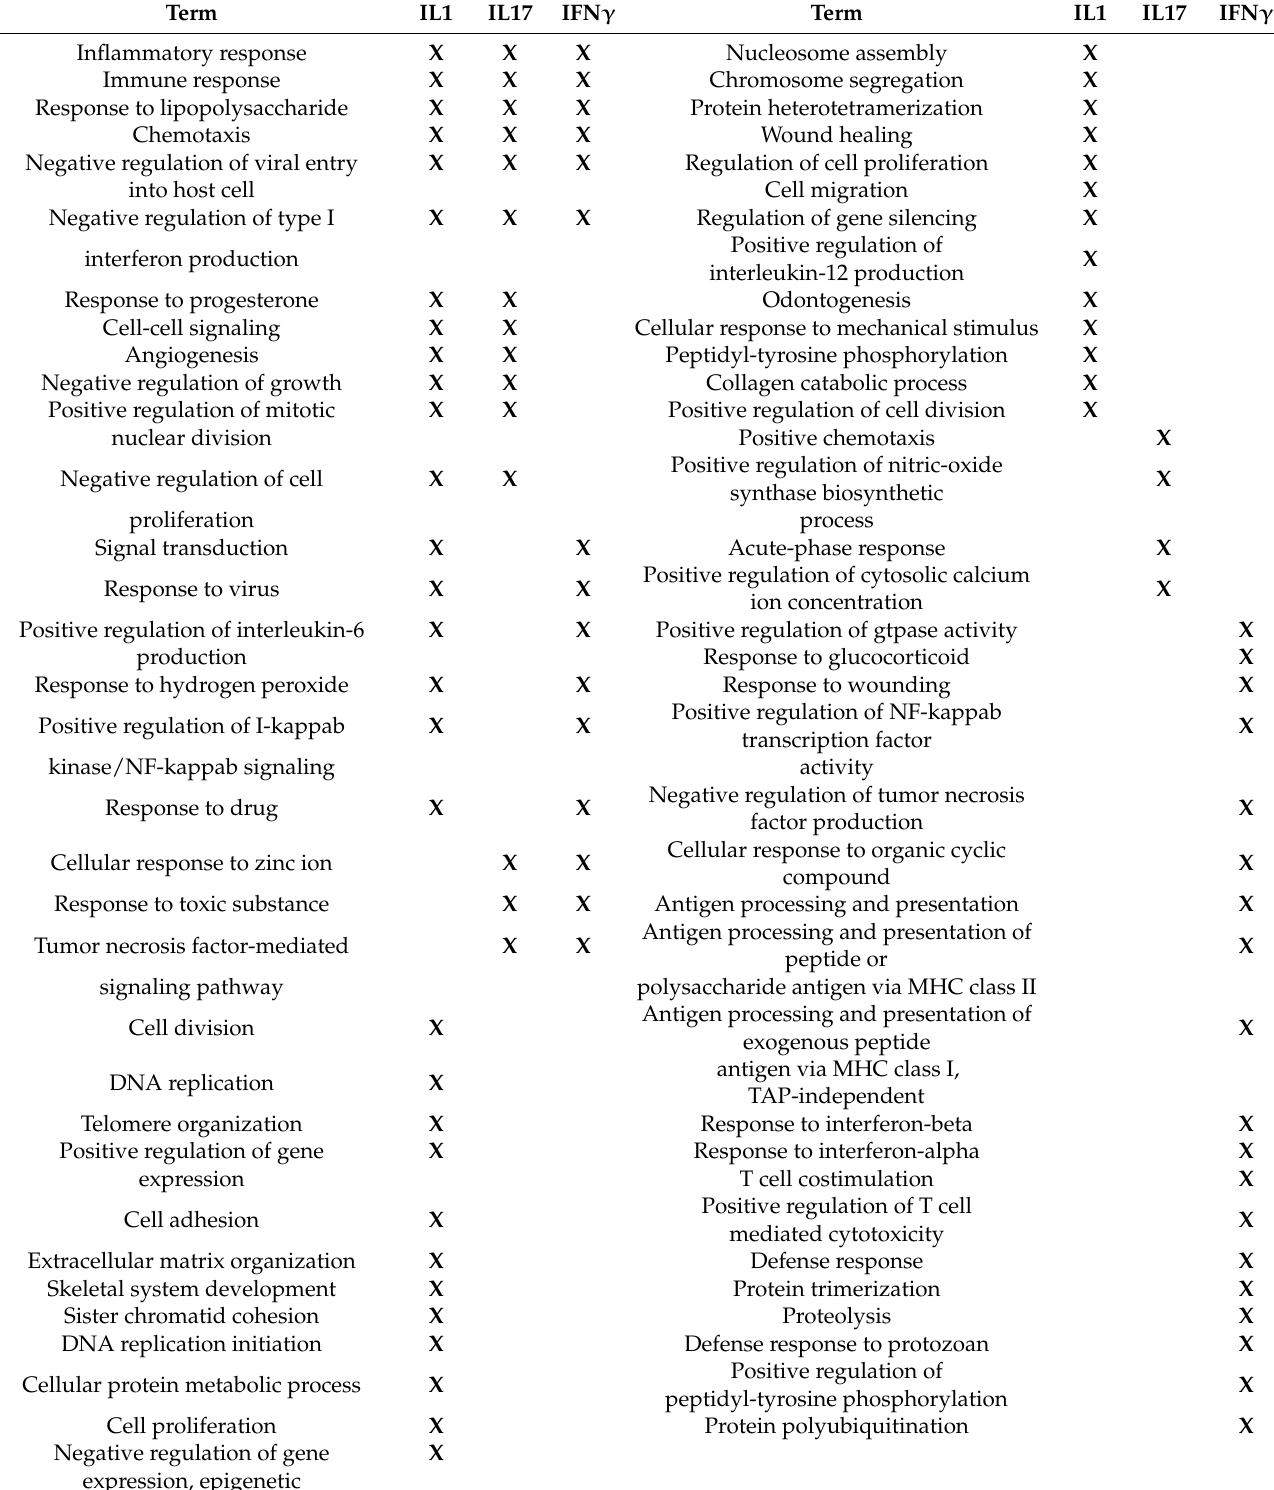
Table 4. GO terms affected by different proinflammatory cytokines. Genes with FC > 2.5 in either direction were analyzed with DAVID, and the resulting lists were reduced with REVIGO. GO terms significantly affected (with FDR-corrected p -value < 0.05) by a cytokine are marked with an